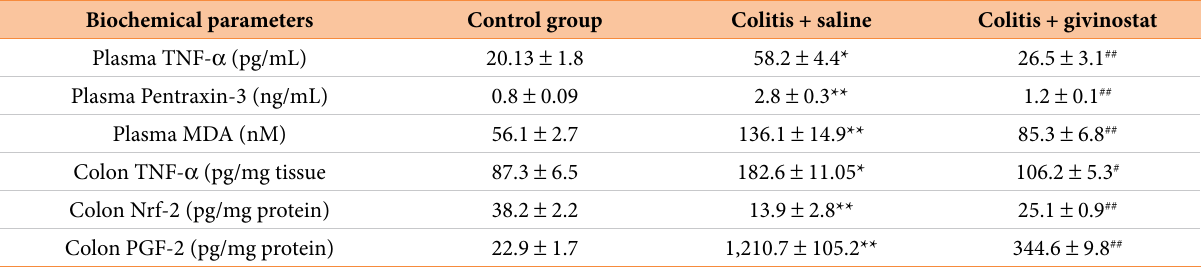
Table 1 - Biochemical results of plasma and colon tissue $ .